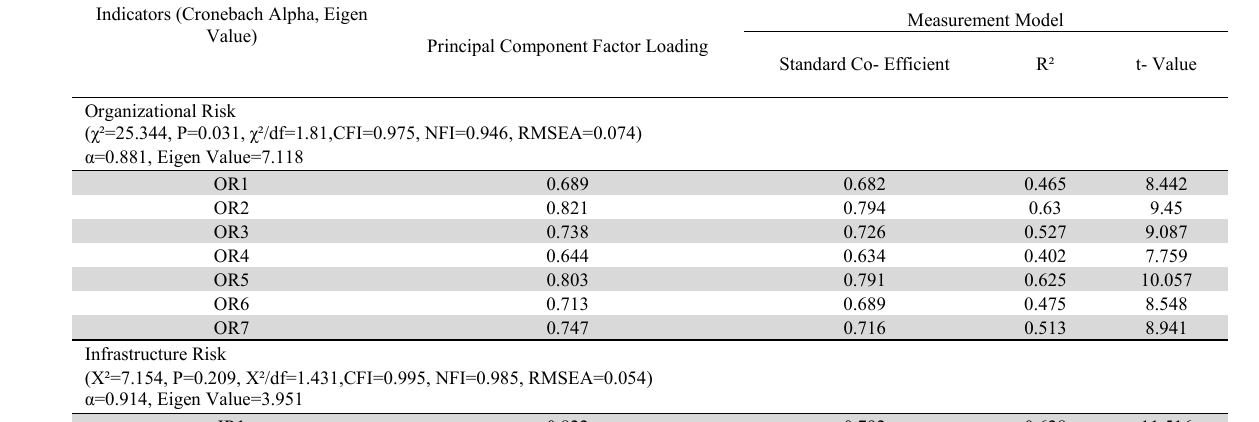
EFA & CFA results of all Risk related